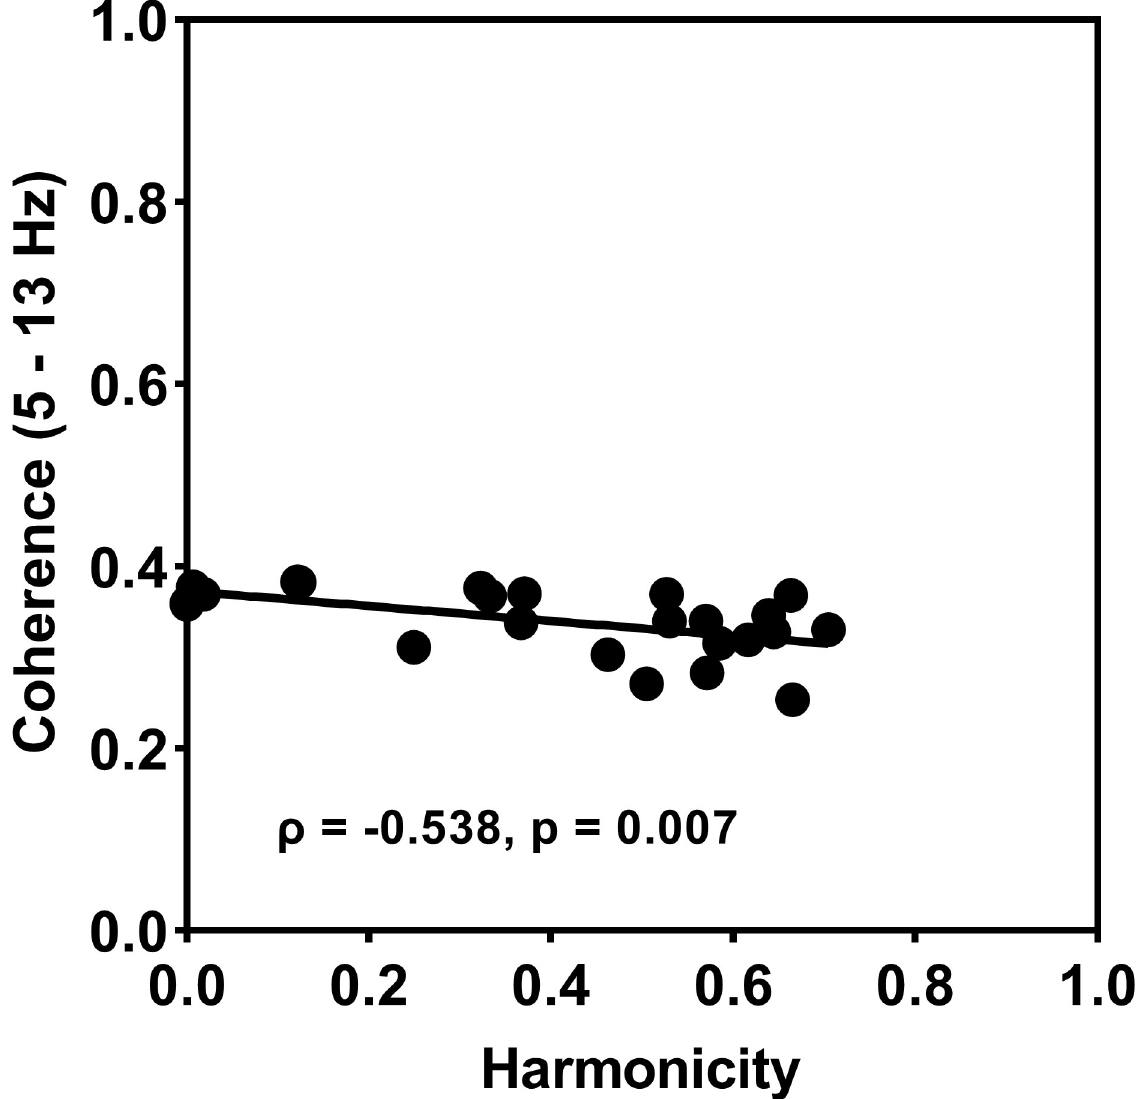
Fig 6. EMG-EMG coherence and harmonicity correlation. EMG-EMG coherence in the alpha bands is significantly correlated with harmonicity of non-dominant effector combined from both groups. The negative value of correlation coefficient indicates an inverse relationship between EMG-EMG coherence and harmonicity of non-dominant effector. The strength of the correlation is moderate to vigorous.